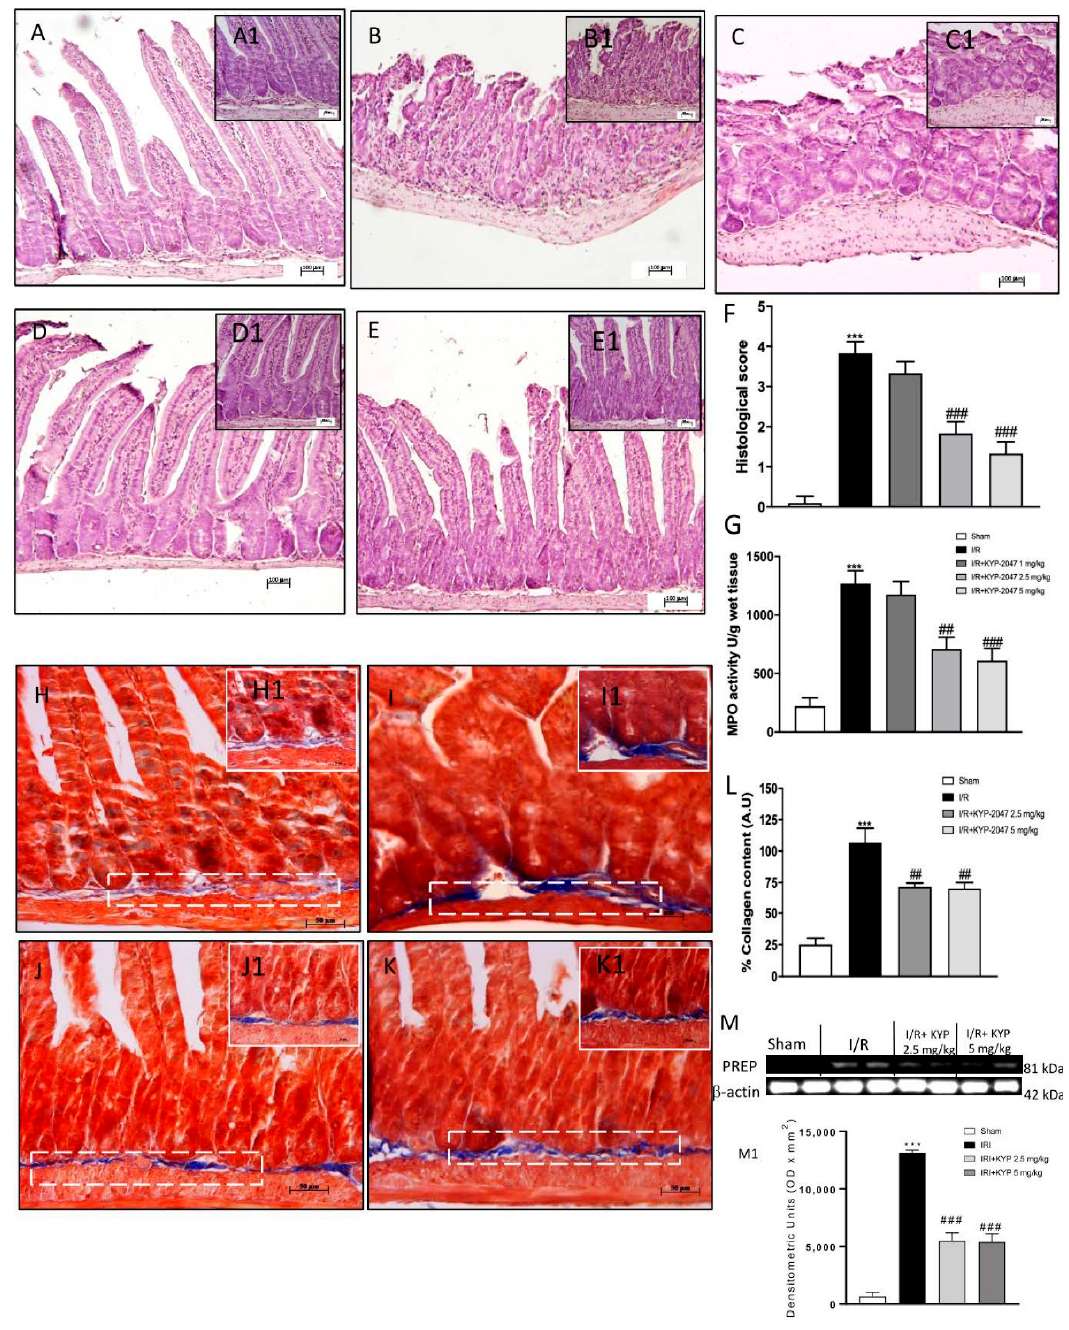
Figure 1. Effect of KYP-2047 on histological damage of intestinal tissue, MPO activity and collagen detection. ( A ) No histological damage was observed in control group. ( B ) Intestinal IRI group showed a significant alteration of the mucosal architecture. ( C ) KYP-2047 1 mg/kg did not show significant reduction of tissue damage. ( D ) KYP-2047 2.5 mg/kg treatment repair of damaged tissue following intestinal IRI. ( E ) KYP-2047 2.5 and 5 mg/kg treatments showed a significant restoration of the architecture of the intestinal mucosa. ( F ) Histological score. ( G ) Effect of KYP-2047 on the MPO activity. Neutrophil accumulation, was observed in the IRI group. KYP-2047 2.5 mg/kg and 5 mg/kg treatments significantly reduced MPO activity. ( H ) No fibrosis was detected in control group. ( I ) IRI group showed a significant increase in fibrosis compared to the control group (blue area). ( J , K ) The degree of fibrosis in the KYP-2047 2.5 mg/kg and 5 mg/kg treated groups was significantly reduced compared to IRI group. ( L ) Quantification of collagen content (%). ( M ) Expression levels evaluation of PREP in the intestine samples. (M1) Densitometric analysis referred to blot in panel M. Data are representative of at least three independent experiments. Data is expressed as mean ± S.E.M. *** p < 0.001 vs. Sham; ### p < 0.001, ## p < 0.01 vs.